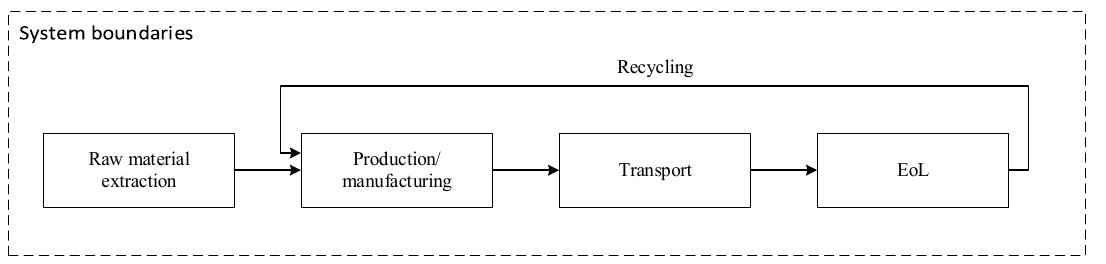
Figure 3. Basic system boundaries are applied for modeling the embodied toxicity throughout the whole life cycle of recycled wood and concrete. All processes needed for the raw material extraction, manufacturing/production, transportation, and end-of-life (EOL) stages are included in the modeled system.